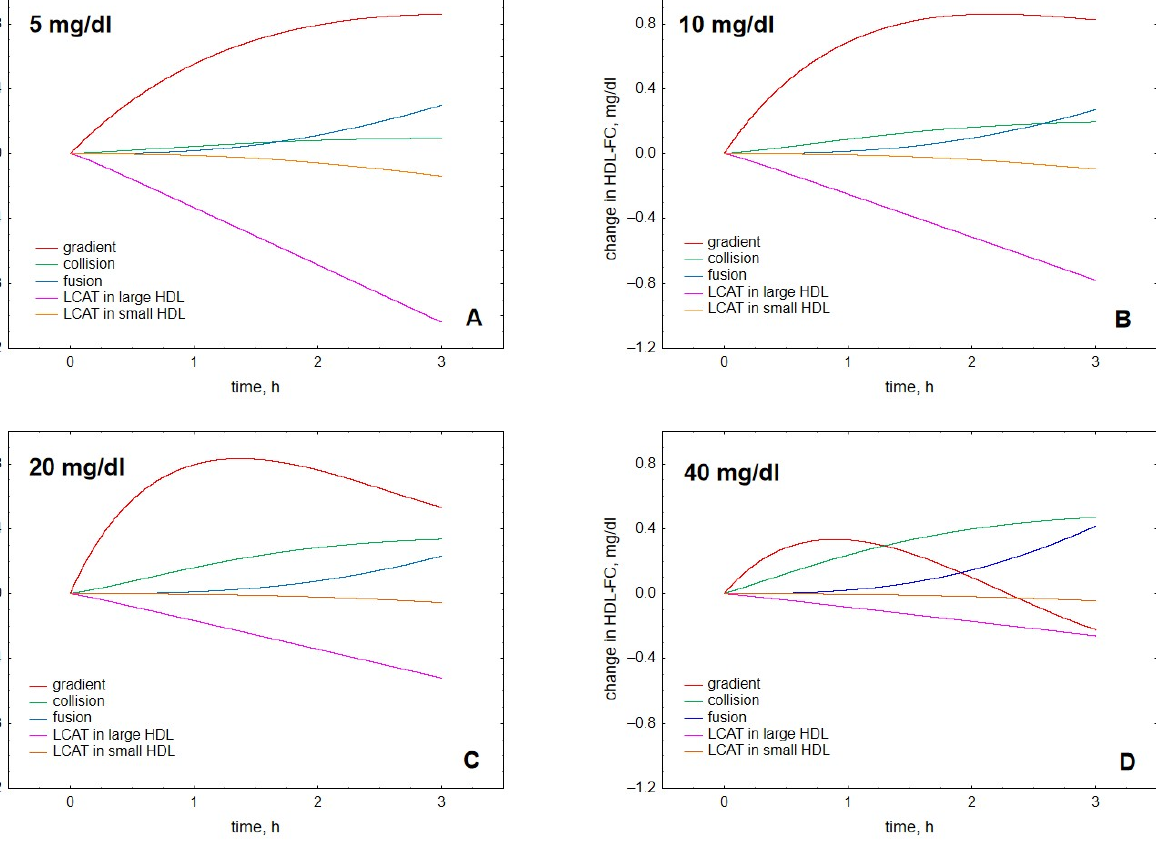
Figure 6. Kinetics of contributions to HDL-FC provided by individual processes , including LCAT- mediated formation of CE from FC in large, lipid-rich, spherical HDL (purple), LCAT-mediated formation of CE from FC in small, lipid-poor, discoidal HDL (brown), FC transfer from VLDL to HDL under the action of FC concentration gradient (red), FC transfer to HDL upon collisions between VLDL and HDL particles (green) and FC transfer to HDL upon fusion of lipid-poor and lipid-rich HDL (blue). Results are separately shown for HDL concentrations of 5 ( A ), 10 ( B ), 20 ( C ) and 40 ( D ) mg total mass/dL (indicated in the upper left corner of each panel). Mathematical modelling was performed under conditions of in vitro TGRL lipolysis described elsewhere [25]. In order to calculate accumulation of FC in HDL, its content at baseline (t = 0) was subtracted from the results of the modelling. Initial concentrations: VLDL-TG, 30 mg/dL; LPL, 190 U/mL. Evaluation of the roles of LCAT and CETP, two major proteins regulating HDL metabolism, showed that increasing their activities resulted in reduced cholesterol ac- cumulation in HDL upon VLDL lipolysis (Figure 8). This result was consistent with experimental observations reported elsewhere